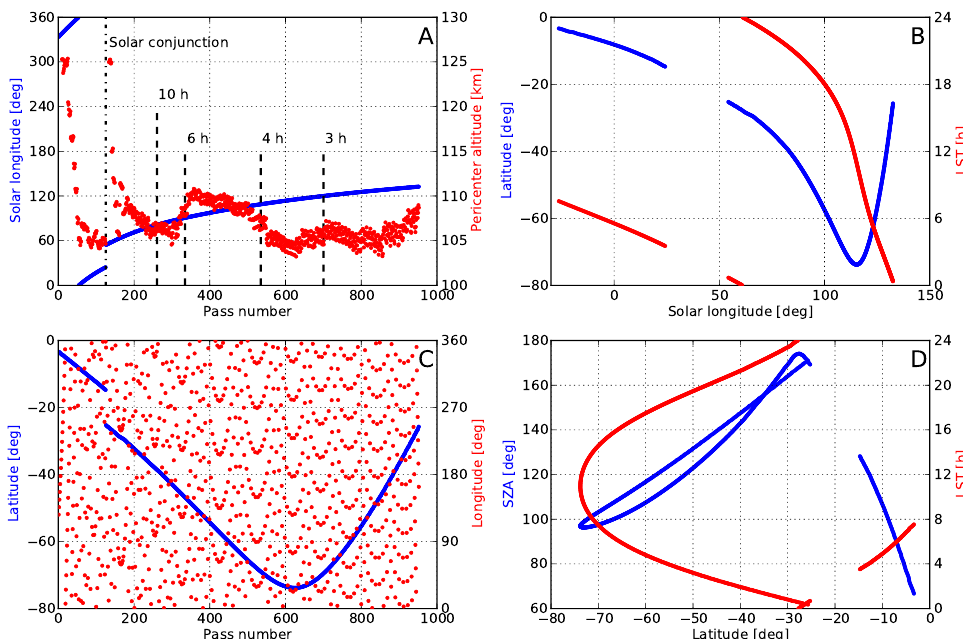
Figure 1. Evolution of the key parameters of the pericenter passes: ( A ) Solar longitude (blue) and pericenter altitude (red) as functions of the pass number; the dash-dotted line highlights the solar conjunction, and the black dashed lines correspond to passes where the given orbital period was reached. ( B ) Latitude (blue) and local solar time (red) as functions of the solar longitude. ( C ) Latitude (blue) and longitude (red) as functions of the pass number. ( D ) Solar zenith angle (blue) and local solar time (red) as functions of the